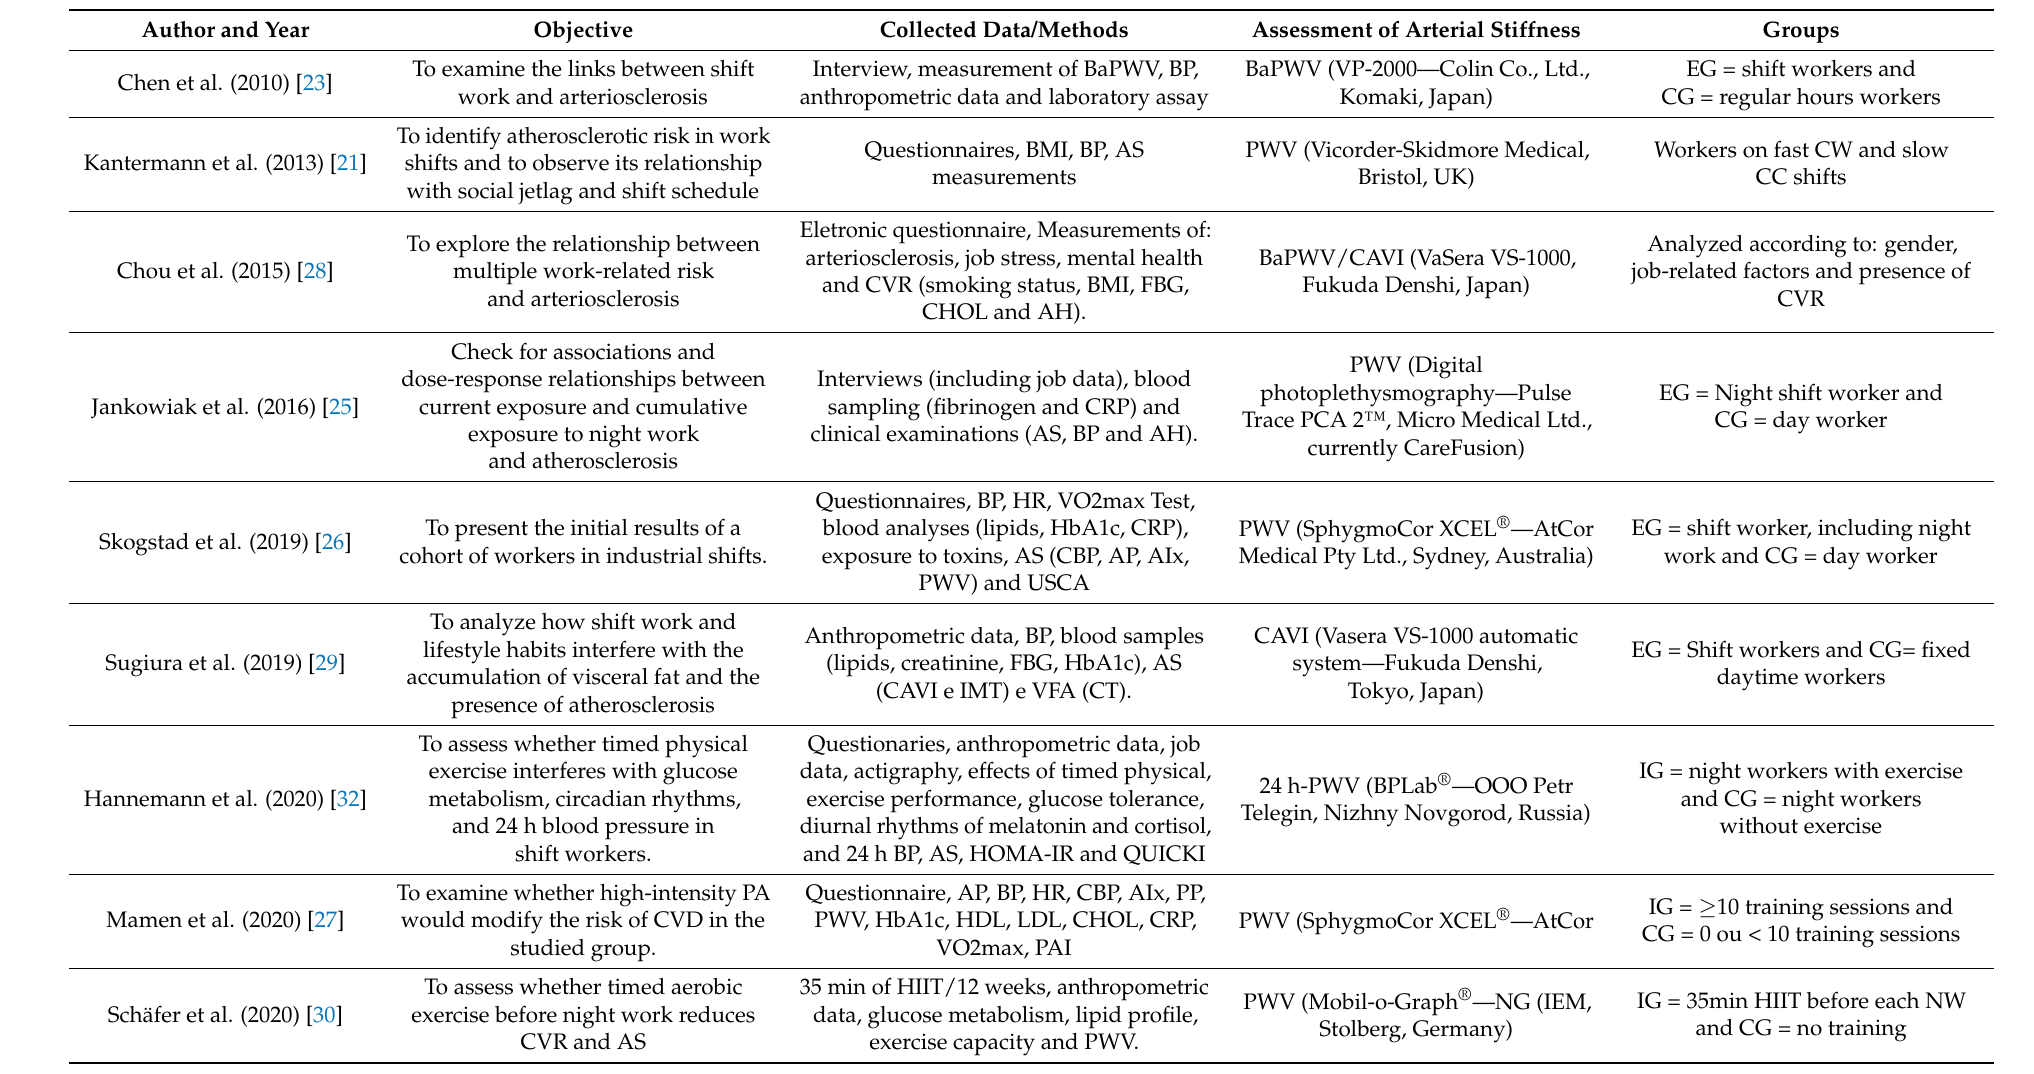
Table 4. Objective of the studies, collected data and methods, assessment of arterial stiffness, and groups